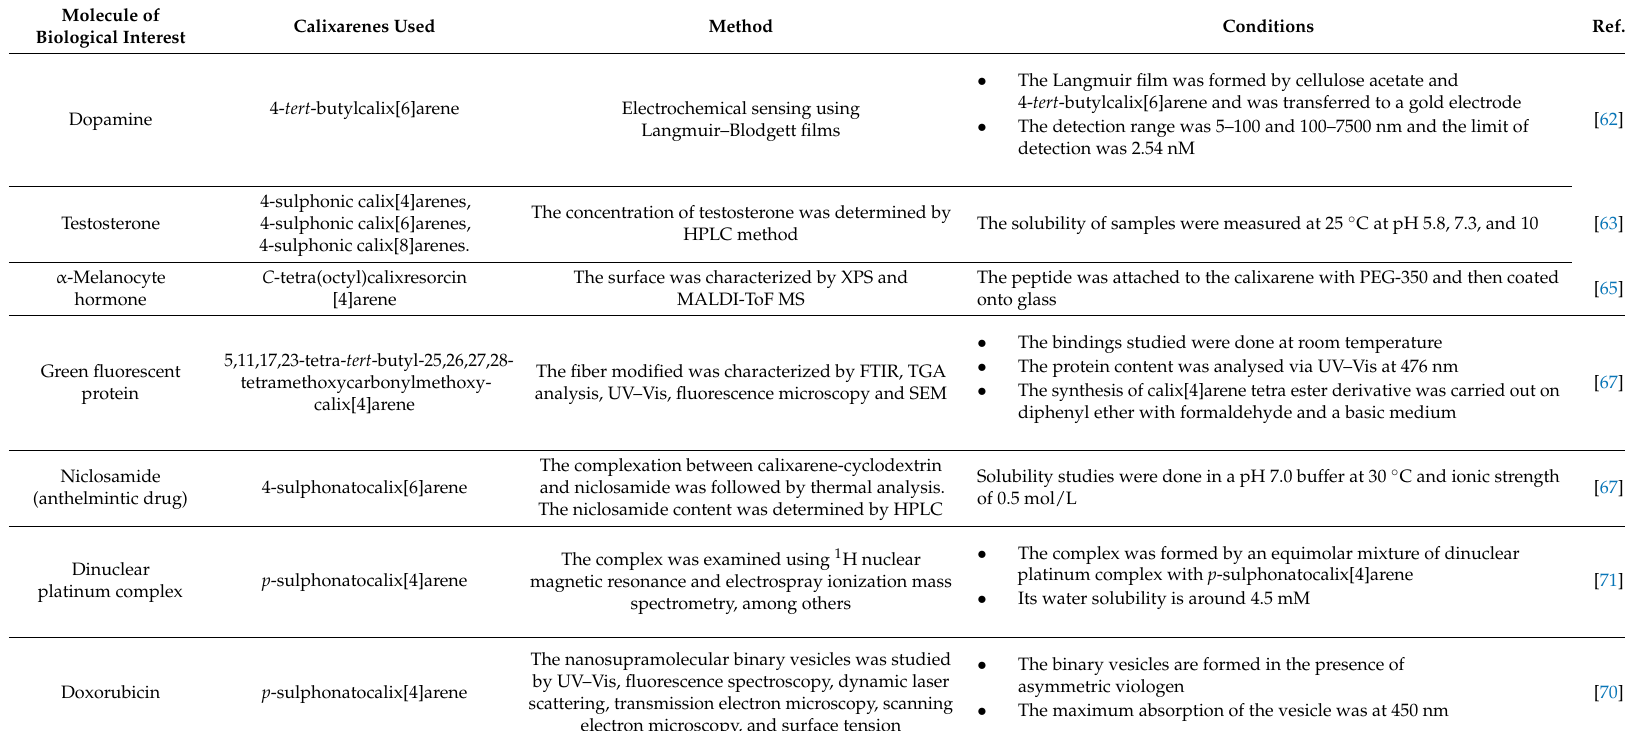
Table 1. Calix[ n ]arenes used for the complexation molecules of biological